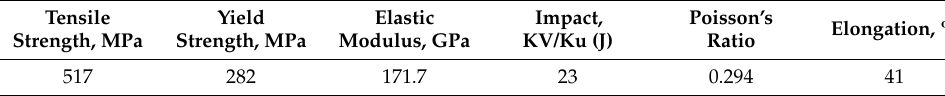
Table 1. Mechanical properties of KHR 45A steel obtained at 21 °C.